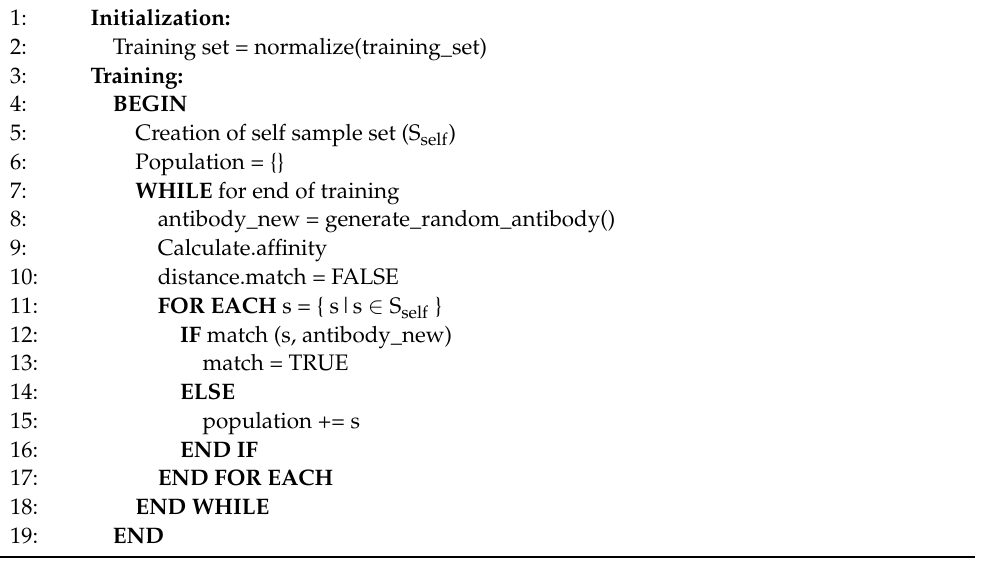
Algorithm 1. Pseudo Code for artificial immune system (AIS) training.